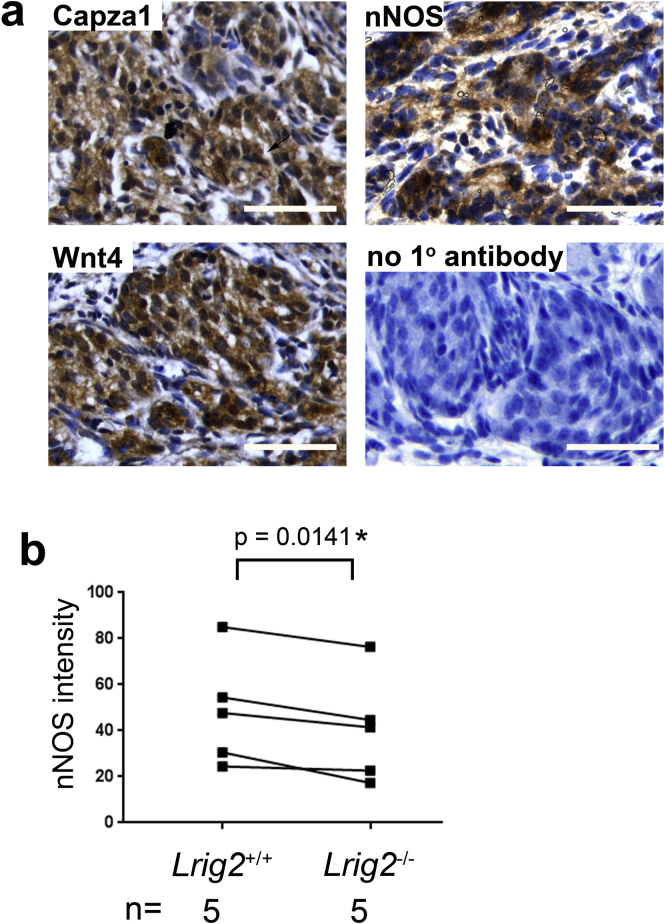
Immunostaining of neonatal pelvic ganglia. (A) Immunohistochemistry for Wnt family member 4 (Wnt4) and capping actin protein of muscle Z-line subunit alpha 1 (Capza1), encoded by 2 transcripts highlighted in unsupervised hierarchical clustering (Figure 3) and neuronal nitric oxide synthase (nNOS), showed that all 3 were detectable in wild-type neonatal pelvic ganglia. The bottom left frame is a negative control with no primary antibody. All sections were counterstained with hematoxylin, with positive immunohistochemical signal in brown. (B) Quantification of nNOS immunohistochemical signals in neonatal ganglia showed a small but statistically significant reduction (Student t- test, P = 0.014) in leucine-rich repeats and Ig-like domains 2 (Lrig2)–/– tissues (mean ± SEM in 5 control subjects = 48.4 ± 10.7 arbitrary units and in 5 mutants = 40.5 ± 10.4). nNOS immunostaining was semi-quantified by taking the average pixel intensity reading for the pelvic ganglia region only in ImageJ.